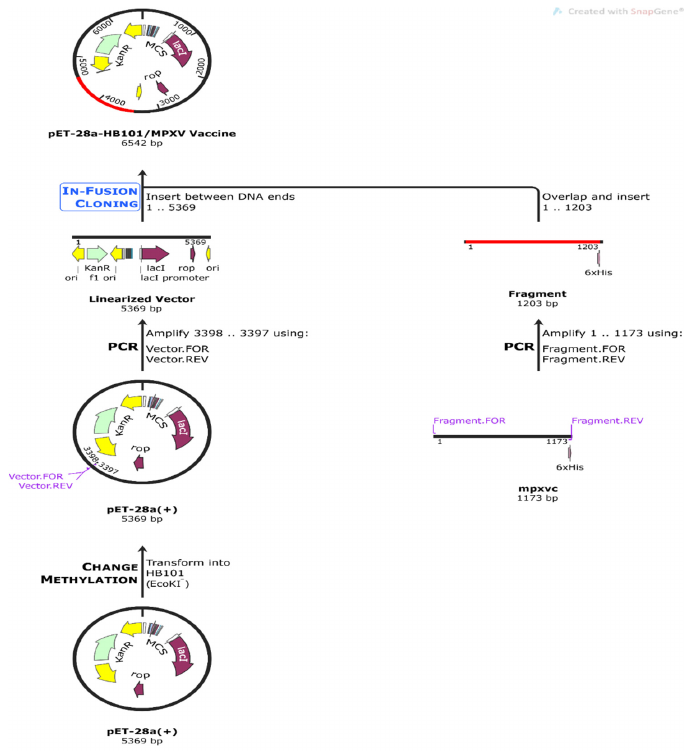
Figure 12. In silico PCR amplification and cloning of vaccine construct.